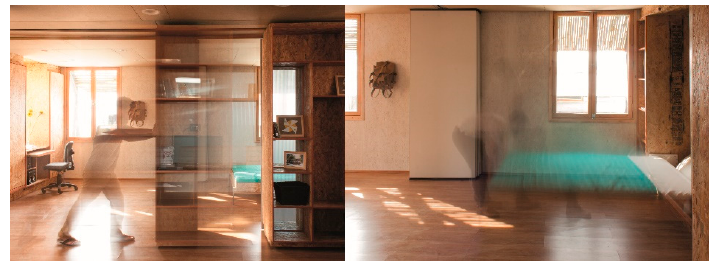
Figure 11. Interior photos of the prototype: mobile furniture and folding bed.